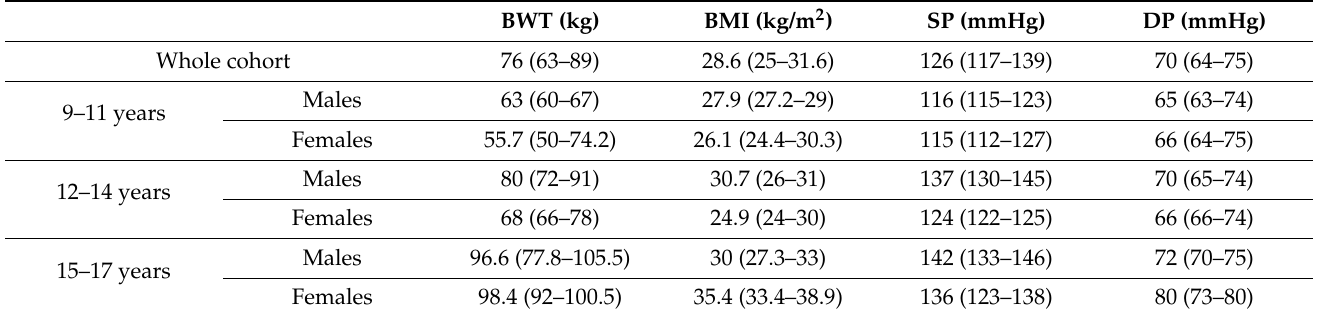
Table 1. The basic characteristics of the